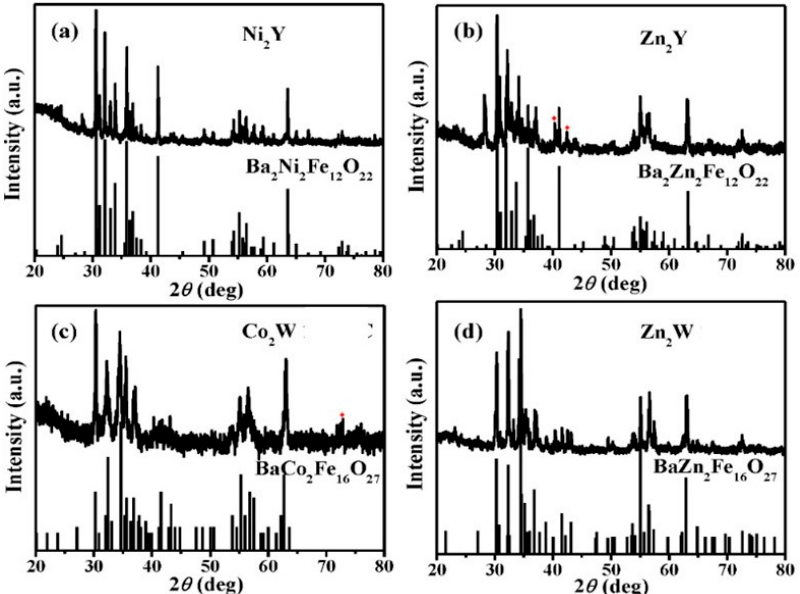
Figure 1. The XRD θ –2 θ pattern for fibers of ( a ) Ni 2 Y, ( b ) Zn 2 Y, ( c ) Co 2 W, and ( d ) Zn 2 W annealed at 1200 °C. The peaks indicated by red dots in ( b ) and ( c ) belong to the impurity phase.